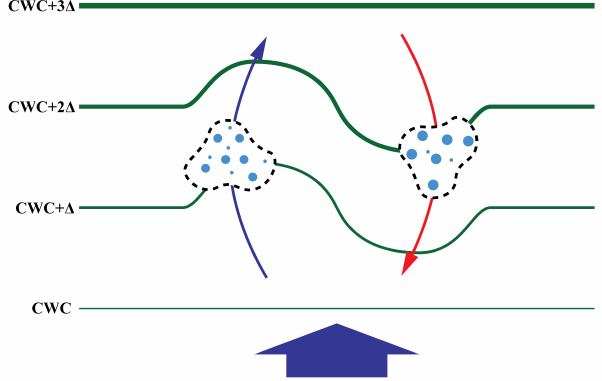
Figure 13. Simplified schematic of spatial responses to the pertur- bation updraft (blue) and downdraft (red) pattern superimposed on broader orographic lift (broad blue arrow). The colored trajectories indicate the approximate path of parcels passing through the kine- matic pattern, following the schema of Houze and Medina (2005). Lines of constant cloud water content (green) indicating the ex- pected deformations due to condensational kinetic effects, with line weight corresponding to relative condensate mass. Cloud parcels circulate within the vertical velocity perturbation pattern and more and smaller drops are located in perturbation updrafts than down- drafts. CWC contours appear flat and unperturbed above and below the vertical velocity fluctuation pattern, as they are determined by the adiabatic ascent in the broader uplift